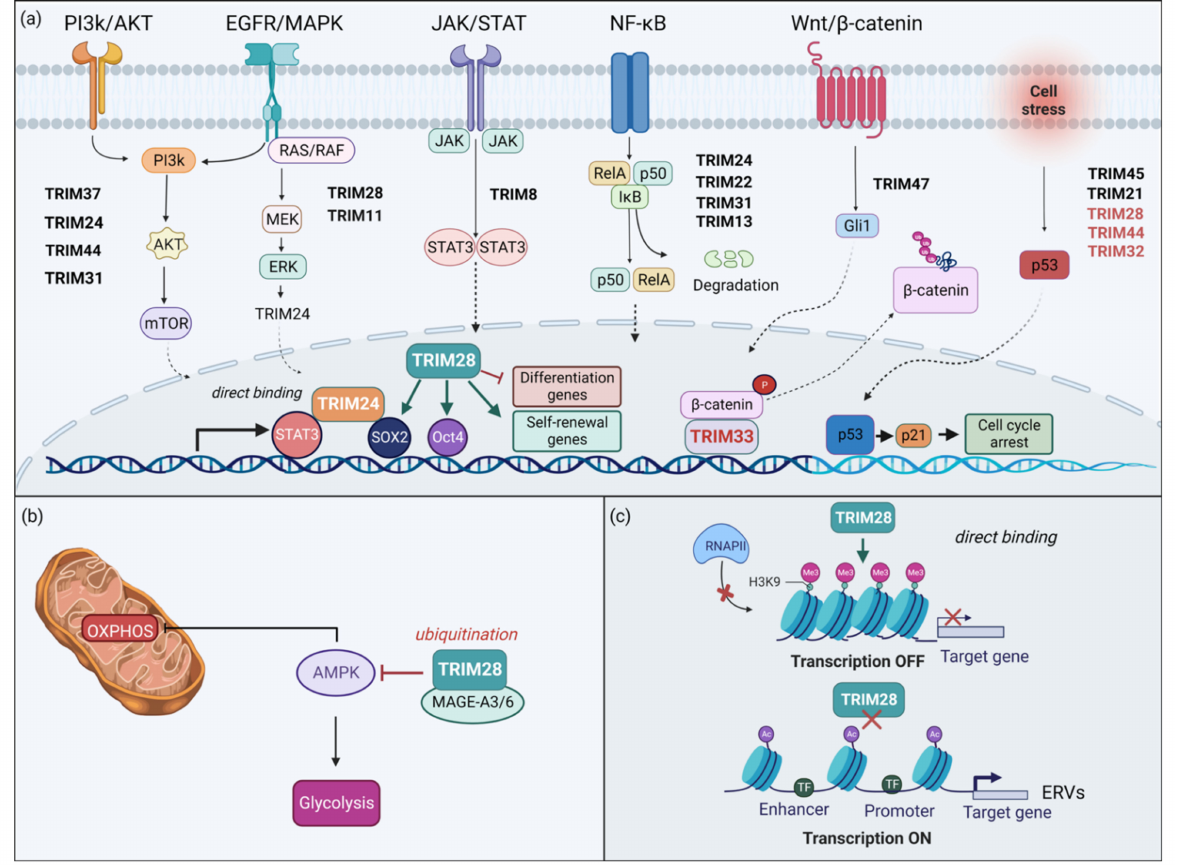
Figure 2. Representation of the multifaced functional roles of TRIM proteins within a brain tumor cell. ( a ) Summary of TRIM proteins and their involvement in critical signaling pathways and gene regulation. Their contribution to activation (positively correlated TRIMs) is marked with bold black letters, while the ones leading to downregulation of the pathway (negatively correlated TRIMs) are shown with red. ( b ) Characteristic example of TRIM28 oncogenic mechanism of function leading to autophagy inactivation and mitochondrial dysfunction through AMPK inhibition in a glioma cell. ( c ) TRIM28 epigenetic mechanism of action for transcription regulation in neuronal progenitor cells. TRIM28 plays a key role in controlling neuronal differentiation processes by establishing local heterochromatin with H3K9me3 enrichment to transposable elements and their target genes which are responsible for neuronal proliferation. Loss of TRIM28 leads to upregulation of the ERV-mediated transcriptional network (created by BioRender.com